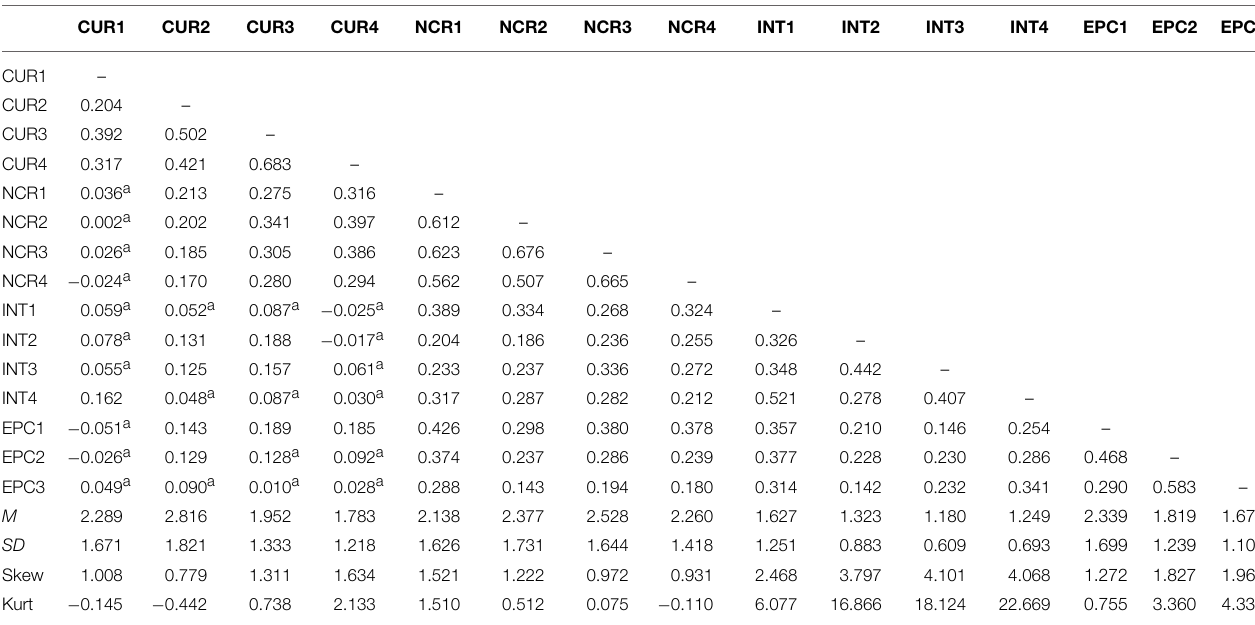
TABLE 5 | Correlations and descriptives for the CCBS items.